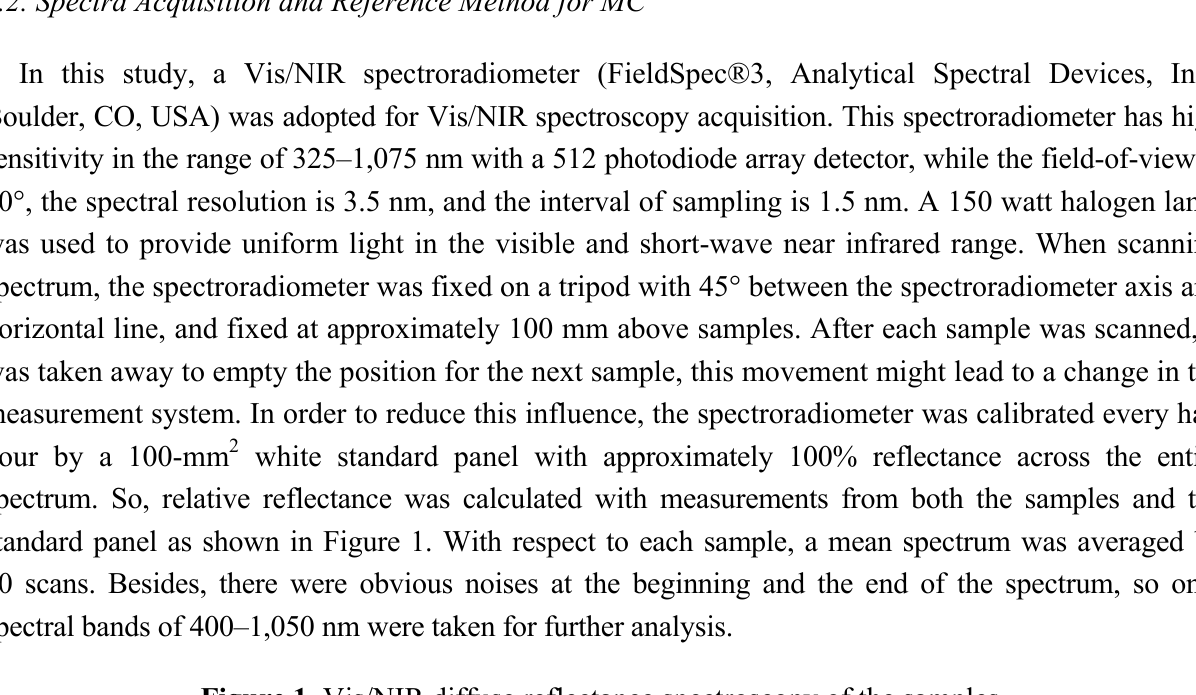
Figure 1. Vis/NIR diffuse reflectance spectroscopy of the